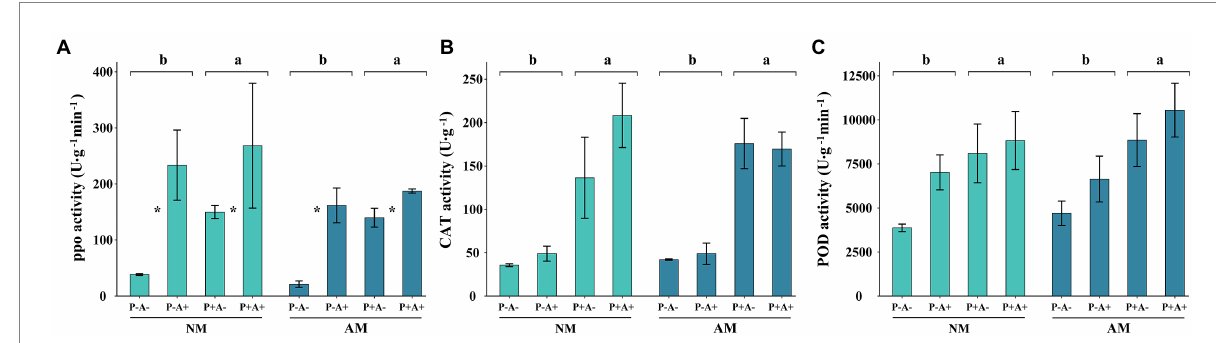
FIGURE 3 (A) PPO activity, (B) CAT activity, and (C) POD activity of Medicago sativa inoculated with Rhizophagus intraradices (AM), infected with Phoma medicaginis (P+), and infested with Acyrthosiphon pisum (A+), or non-inoculated with R. intraradices (NM), non-infected with P. medicaginis (P − ), and non-infested with A. pisum (A − ). All values are the mean ± SEM of three biological replicates. Different letters above pairs of bars indicate a significant difference in the comparison at p < 0.05. In (A) asterisks indicate a significant difference between P − A − and P − +, or P+A − and P+A+, as